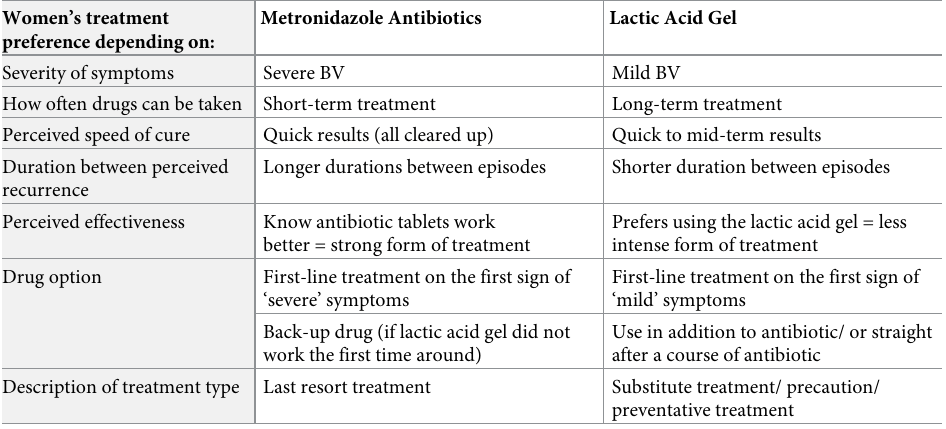
Table 2. Summary of women’s treatment preference based on differences between drug treatments. Women’s treatment preference depending